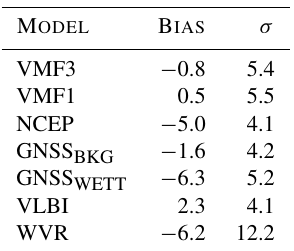
Table 2. Bias and standard deviation in zenith wet delay (cid:49)L z w (mm) between the reference solution from radiosonde data and the other solutions.